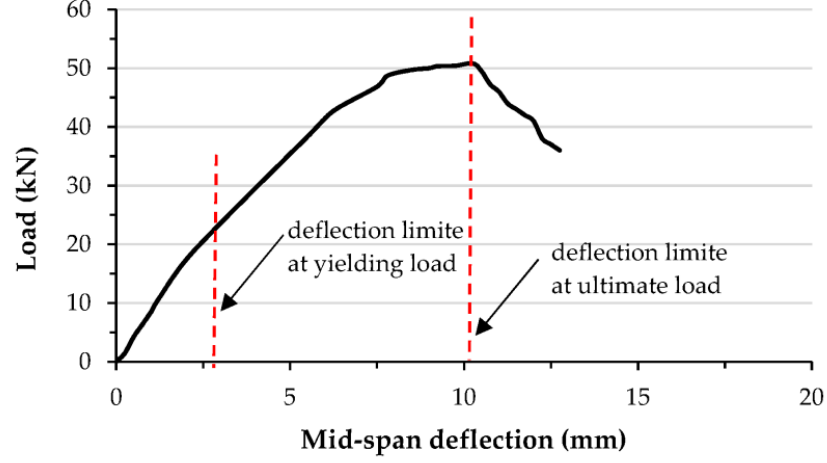
Figure 14. Typical procedure for estimating the ductility index (B-CM0).